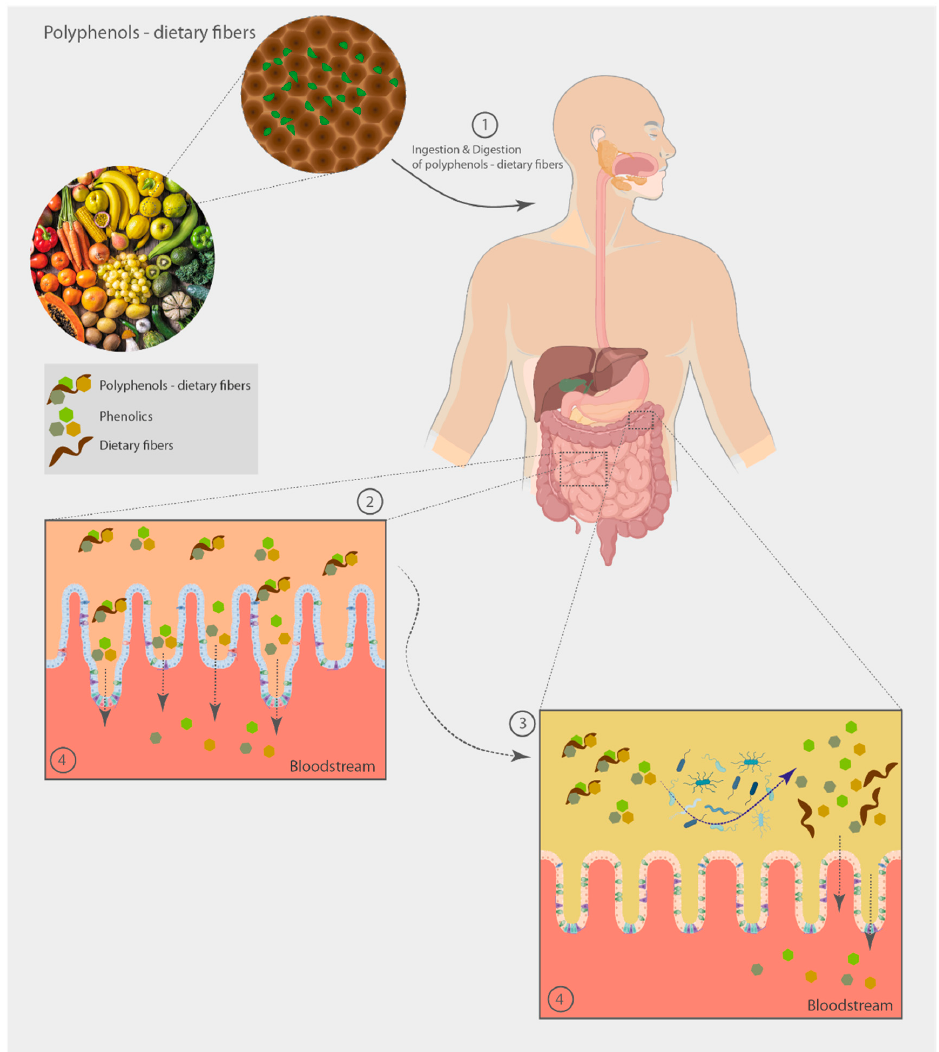
Figure 3. Overview of the metabolic fate of polyphenol-dietary fiber conjugates through the gut. 1—polyphenols can be ingested both in free form and conjugated to the dietary fibers components of plant cell walls; 2—only a small percentage of polyphenol-dietary fiber conjugates can be absorbed through the small intestine mucosa. Others reach the lower gut intact, reducing the local oxidative stress and modifying the microbiota composition; 3—non-absorbed polyphenol-dietary fiber conju- gates reach the lower gut where they are fermented by the colonic microbiota, releasing absorbable polyphenols and producing absorbable metabolites. The action of the microbiome on dietary fibers produces mainly SCFA and gases; 4—polyphenols and their metabolites can be absorbed into the bloodstream, through passive diffusion and/or active transport, reaching tissues and organs and exerting biological